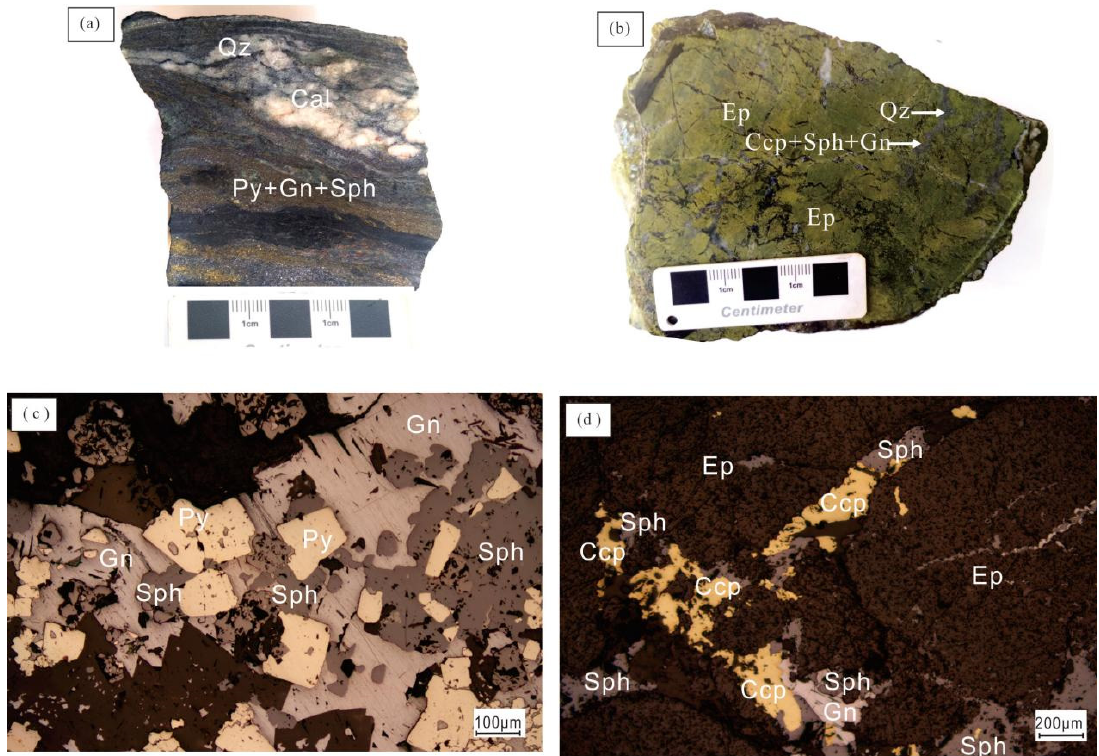
Figure 5. Hand specimens and microscopic photos of the ores from the Caiyuanzi deposit. ( a ) Disseminated-banded Pb–Zn ore sample (CYZ-1); ( b ) disseminated-net vein Pb–Zn ore (CYZ-2); ( c ) pyrite replaced and enclosed by galena and sphalerite; ( d ) sphalerite, galena, and chalcopyrite, forming network veins occurring along the wall rock fractures, where galena and chalcopyrite al- ternate with sphalerite. Abbreviations are as follows: Py, pyrite; Gn, galena; Sph, sphalerite; Qz, quartz; Ccp, chalcopyrite; Ep, epidote; Cal, calcite.